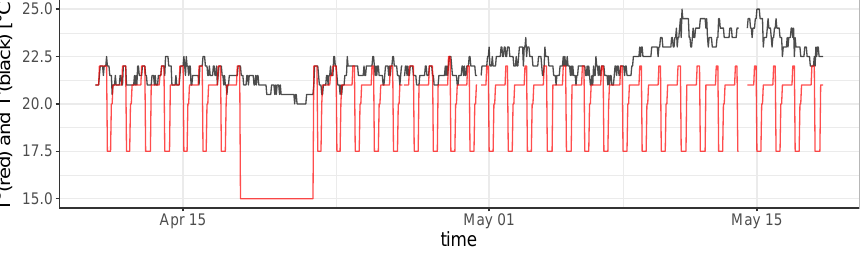
Figure 6. Actual set point and indoor temperature for one household. Figure 7 shows the residual analysis of the demand-side model of the analyzed household along the training period. As can be observed, the residuals are not auto- correlated, they follow a Gaussian distribution and the variance is homocedastic along the time. These three conditions set that the residuals are independent and identically distributed, meaning they achieve the white noise condition and the model is properly trained and considered as valid. To validate the model with new data, and therefore to assess its forecasting accuracy, the daily aggregated MAPE and RMSE indicators were computed. They yield values are 1.4% and 0.45 ○ C, respectively. These error ranges are very satisfactory and demonstrate the validity of the model for simulations of long term